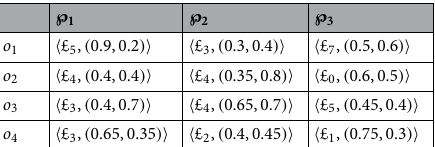
Table 5. Normalized decision matrix provided by d 2 .